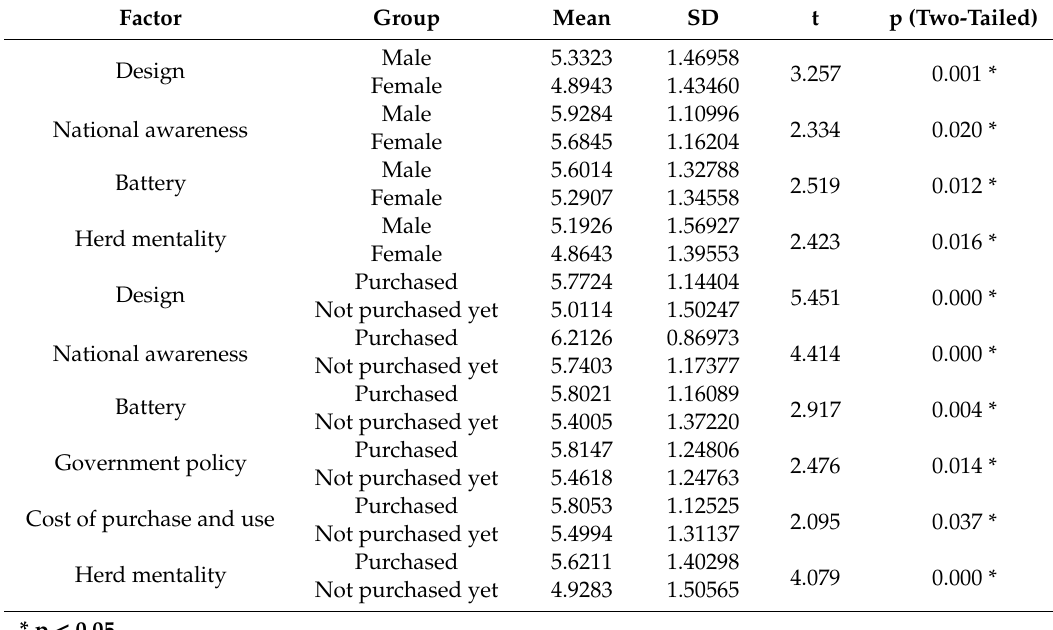
Table 9. Summary of independent sample t